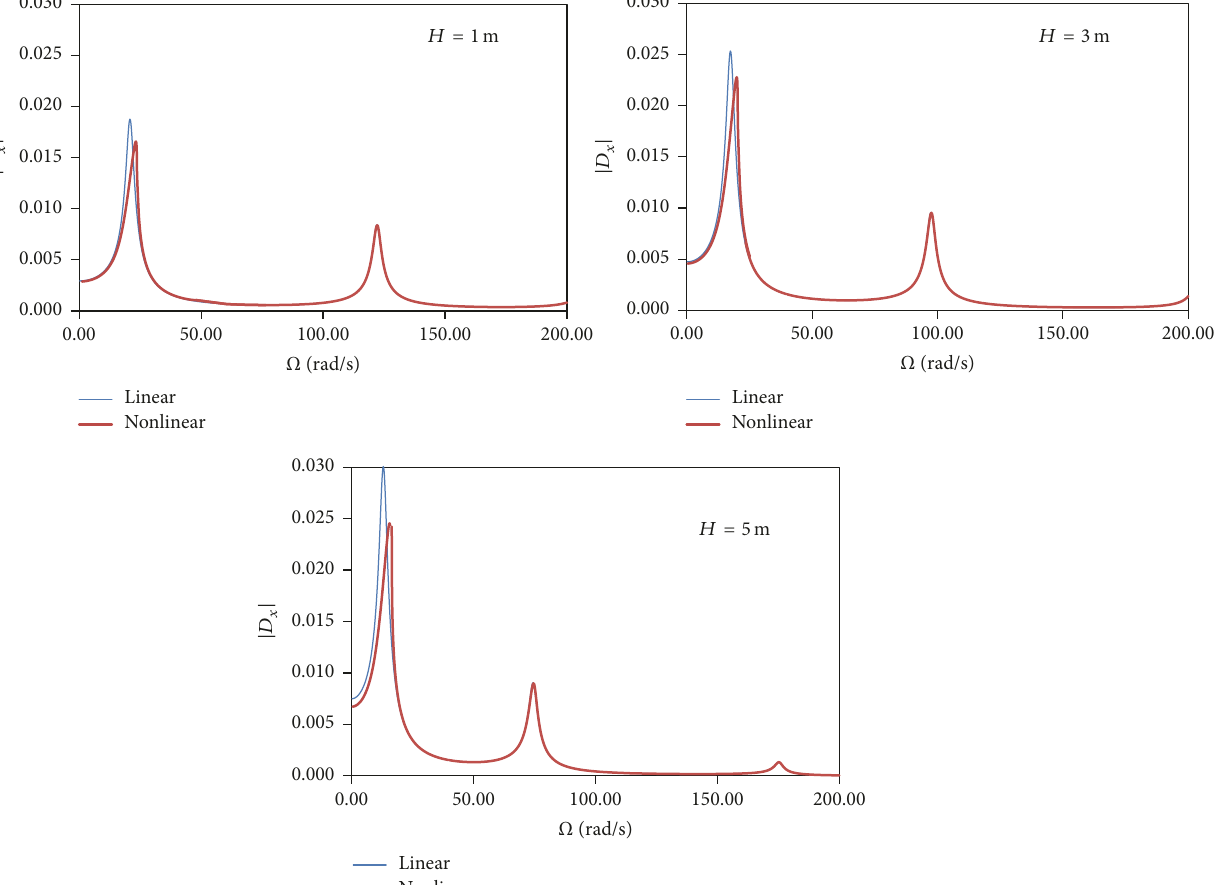
Figure 10: Influence of the roof height on the nonlinear response of the arched-roof frame under horizontal excitation. 𝐴 𝑥 = 0.96𝑔 .